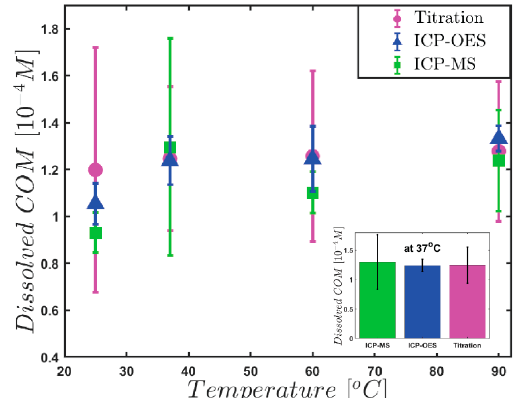
Figure 2. Measured dissolved COM in ultrapure water as a function of temperature for the three analysis methods. Average values and their standard deviations are given for titration (magenta circles), ICP-OES (blue triangles), and ICP-MS (green squares). The error bars denote the standard deviation of independent repetitions. The inset shows the solubilities measured at body temperature. The large standard deviations observed with the titration method might be due to manual nature of titration method where the experimentalist measures the titrated volume by judging color change by eye. In addition, saturated solution preparation for titration experiments were conducted with a beaker placed on a hot-plate. We suspect that hot-plate used in titration is less accurate in controlling the temperature compared to automated EasyMax 102 (Mettler Toledo, Columbus, OH, USA) used in saturated solution preparation for ICP-MS and ICP-OES. The larger variation observed with ICP- MS compared to those of the ICP-OES were more of a surprise as in general the ICP-MS can detect